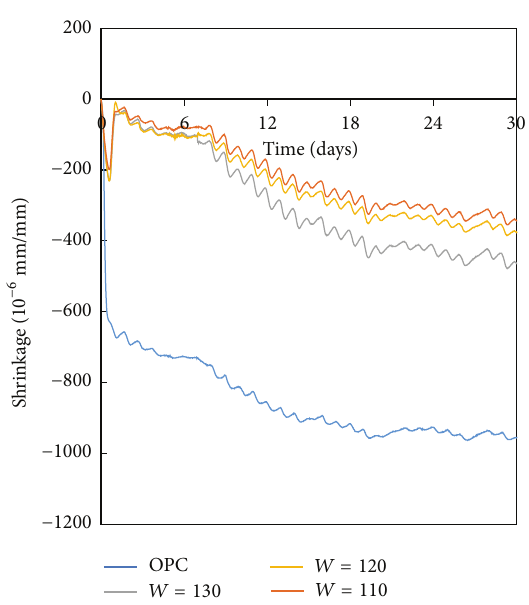
Figure 8: The drying shrinkage of high volume fly ash HFC in